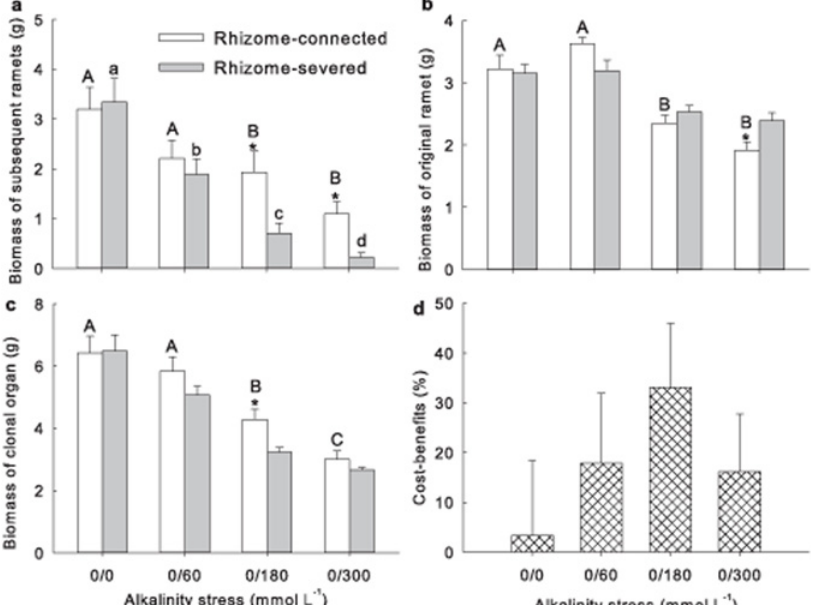
Fig 3. Effects of alkalinity stress and rhizome connection on a) the biomass of daughter and b) mother ramets, c) the total biomass of clonal organs and d) cost-benefits of clonal integration. Bar groups with different capital letters indicate significant differences ( P < 0.05) between the four levels of alkalinity in the rhizome-connected treatment. Bar groups with different lowercase letters indicate significant differences ( P < 0.05) between the four levels of alkalinity in the rhizome-severed treatment. Asterisks indicate significant differences ( P < 0.05) between rhizome-connected and rhizome-severed